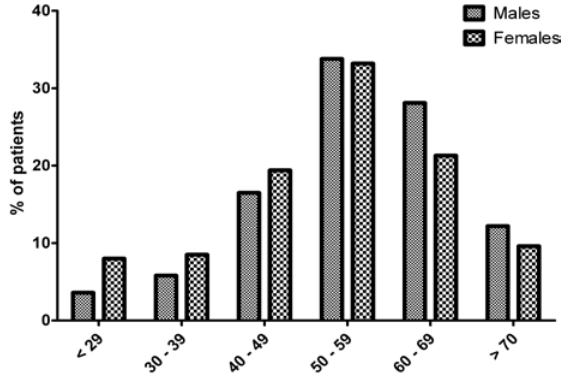
Figure 1. Age and sex distribution of patients with incidentally discovered adrenal